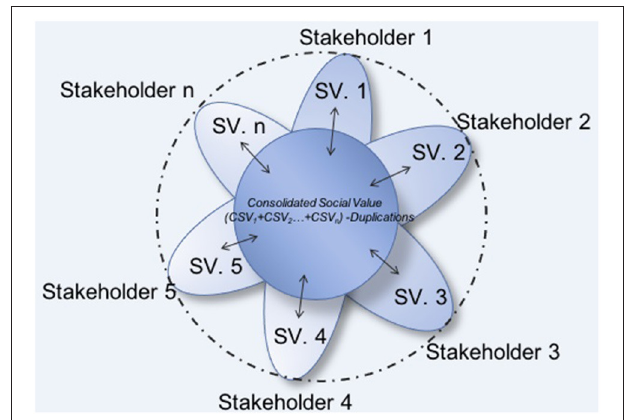
FIGURE 1 | Graphical representation of the ISV model. Source: adapted from Retolaza and San-Jose (2016).